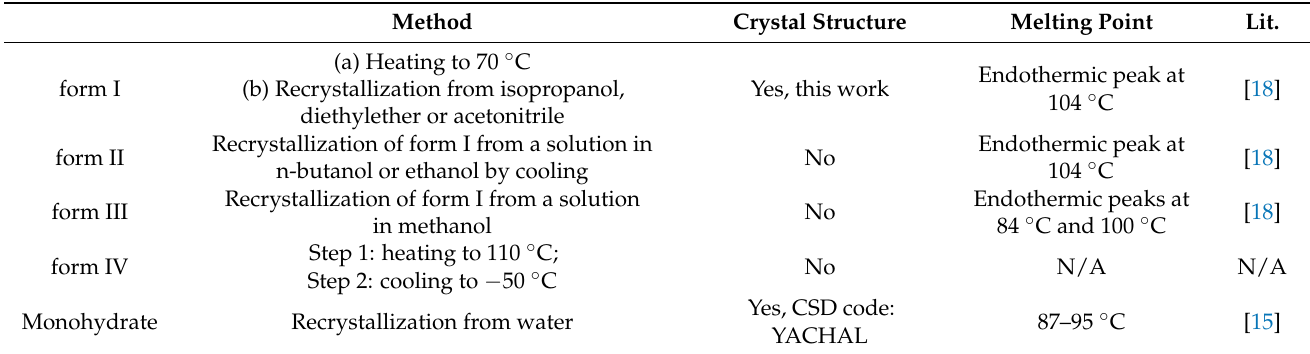
Table 2. The different crystalline forms of anhydrous Famiclovir and the information obtained about each form in the literature. Method Crystal Structure Melting Point